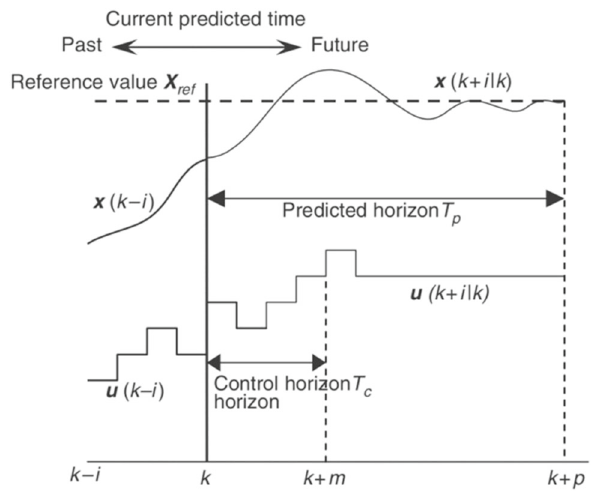
Fig. 8 Process of RHC